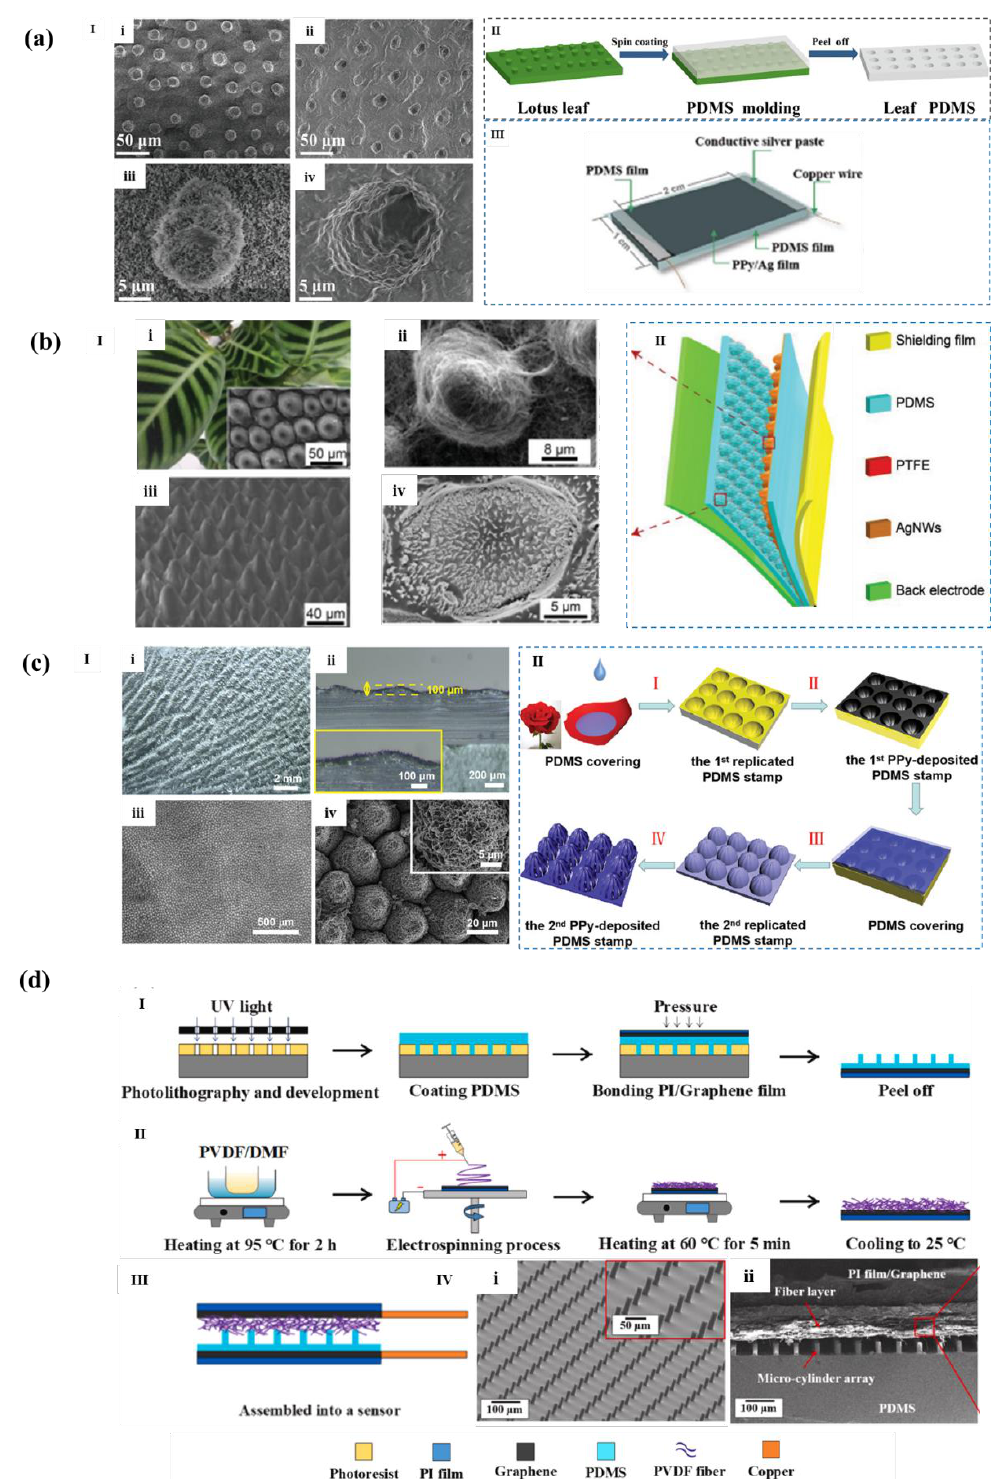
Figure 7. ( a , I ) SEM images: ( i , ii ) lotus leaf; ( iii , iv ) microstructural PDMS films; ( II ) The manufacturing process of lotus leaf-like sharp bulge patterned PDMS film; ( III ) The structure of flexible pressure sensor [47]. ( b , I ) SEM images: ( i ) C. Zebrine leaves; ( ii , iii , iv ) bionic microstructures. II ) The structure of Teng e-skin flexible pressure sensor [48]. ( c , I ) image of rose-like sharp bulge microstructure: ( i , ii ) optical images; ( iii , iv ) SEM images. ( II ) Manufacturing process of rose-like sharp bulge microstructural PDMS film [49]. ( d ) Schematics of ( I , II ) the fabrication process of microstructured electrodes; ( III ) the assembled array as a capacitive pressure sensor; ( IV ) SEM images of the composite dielectric layer. ( i ) 45° tilt-view, ( ii ) Cross-sectional view [52].